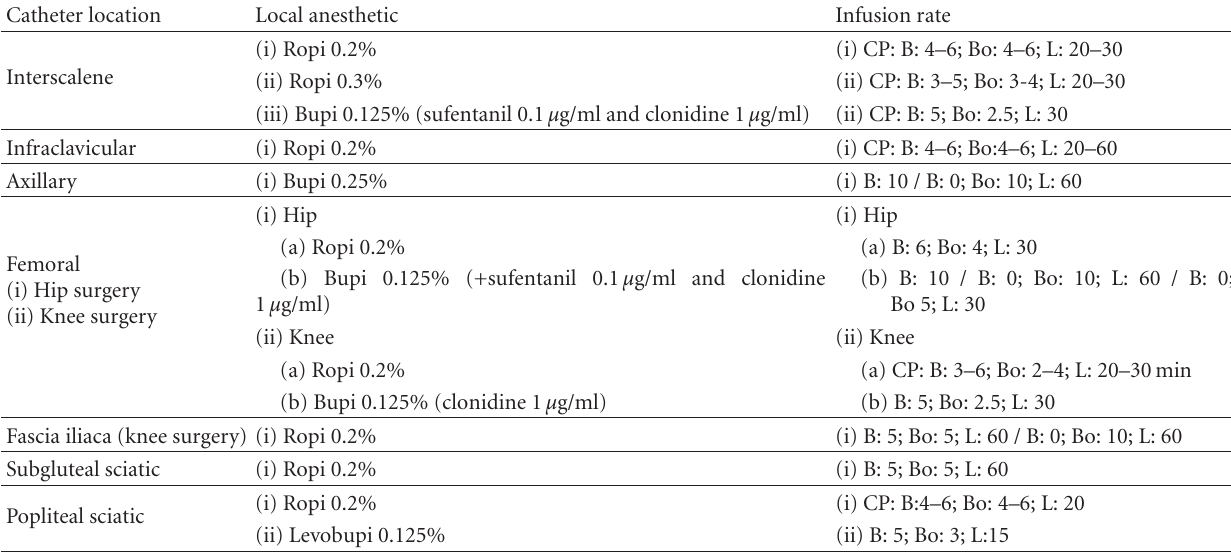
Table 3: Recommended doses of di ff erent local anesthetics for di ff erent catheter locations and their administration regimen according to clinical practice of the authors (CP), own publications or based on selected randomized controlled trials. Ropi: ropivacaine; Bupi: bupivacaine; B: basal rate (ml/h); Bo: bolus (ml); L: lockout (min). The used literature for Interscalene [55, 58, 153–157],